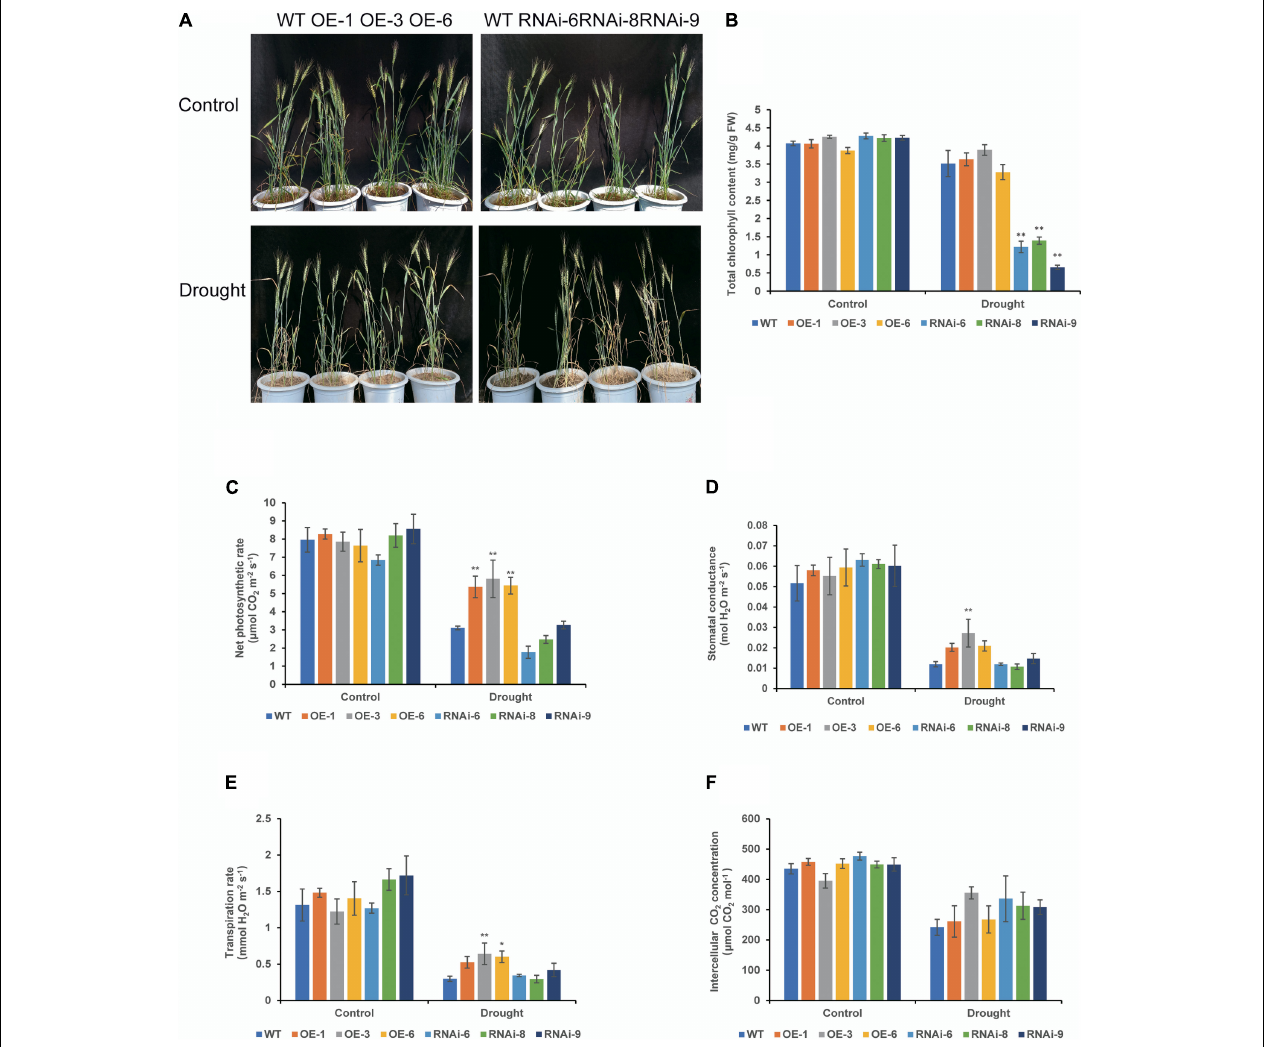
FIGURE 4 | Phenotype and photosynthetic parameters of WT and TaNRX1 transgenic wheat under drought stress at the heading stage. (A) Phenotype of 45-day-old WT and TaNRX1 transgenic wheat in normal water supply and 21 days of drought stress (the soil relative water content was 35–40%). (B) Total chlorophyll content ( n = 4). (C) Net photosynthetic rate ( n = 6). (D) Stomatal conductance ( n = 6). (E) Transpiration rate ( n = 6). (F) Intercellular CO 2 concentration ( n = 6). Data represent the mean ± SD. WT, wild type; OE-1–OE-6, TaNRX1 overexpression T 3 homogeneous lines; RNAi-6–RNAi-9, TaNRX1 RNA interference T 3 homogeneous lines. * P < 0.05, ** P < 0.01 represent the significant difference between the transgenic line and the WT,